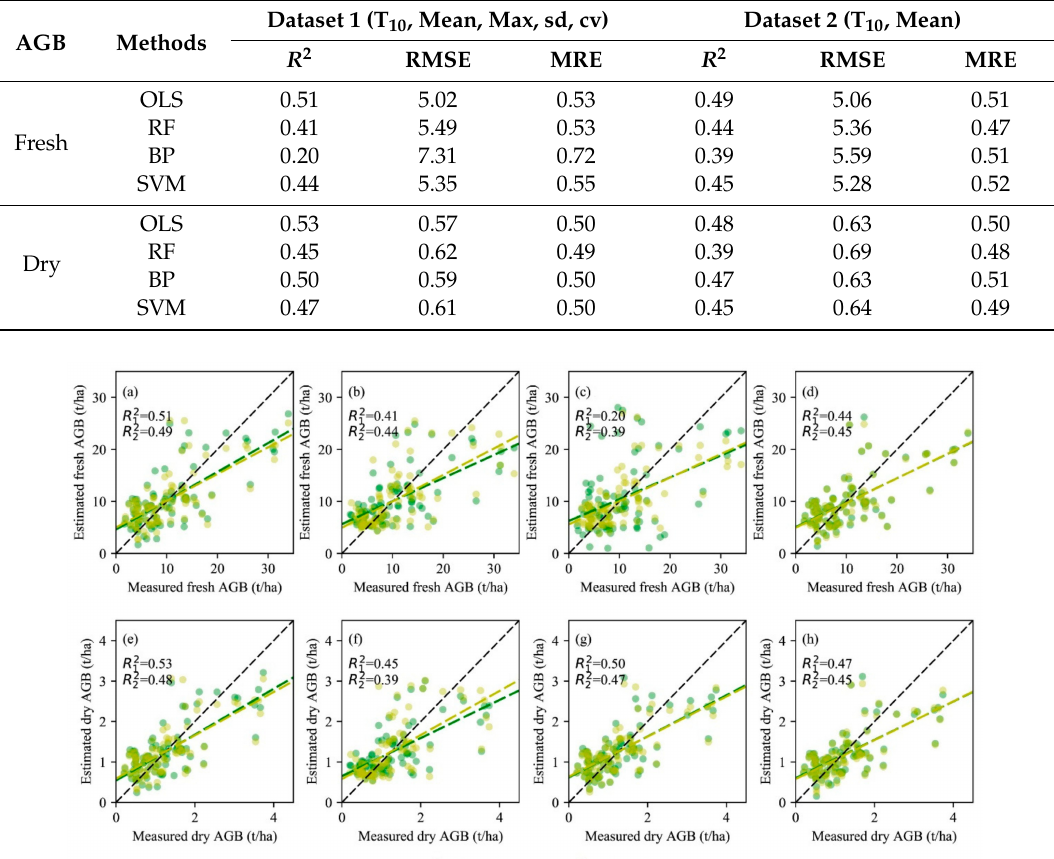
Table 3. R 2 , root mean square error (RMSE), and mean relative error (MRE) for linear regression between measured fresh / dry AGB and estimated fresh / dry AGB based on the multiSPEC-4C SfM point clouds using four algorithms ( n = 89).